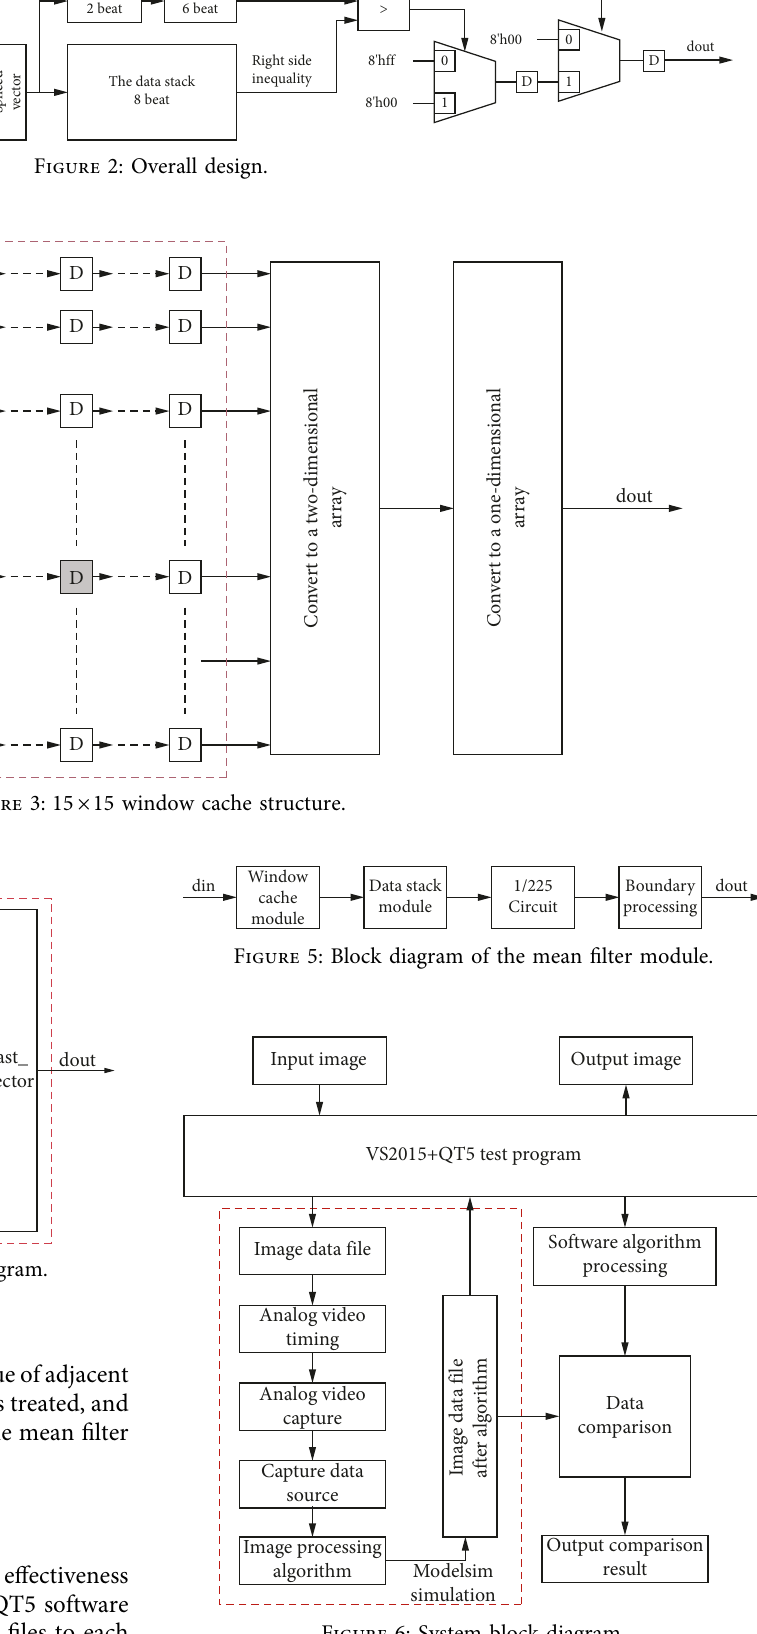
Figure 6: System block diagram.